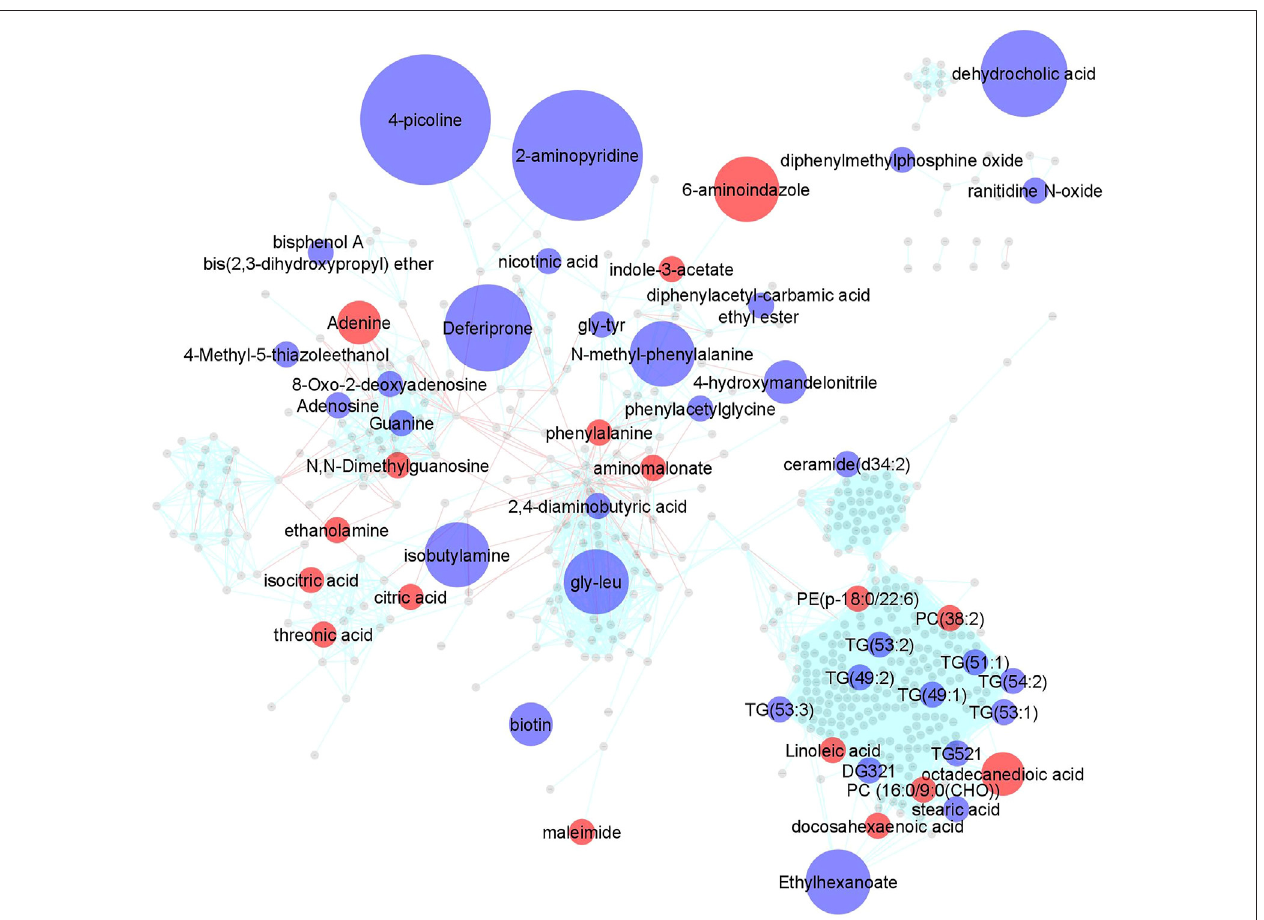
FIGURE 1 | Changes in the plasma metabolomic pro fi le in children with JIA following the initiation of MTX. Metabolite levels were determined at baseline and after 3 months of MTX therapy. Changes in metabolite levels were determined by paired analysis and metabolic changes were mapped using MetaMapp and visualized in Cytoscape3.7.1. Metabolites foundtosigni fi cantlychange basedonap-value < 0.05were colorcodedand indicateeither anincrease (red) ordecrease (blue)following initiation of MTX. Node size is proportional to measured fold-change. Red lines between nodes represent KEGG reaction pairs, while blue-green lines represent pairing based on chemical